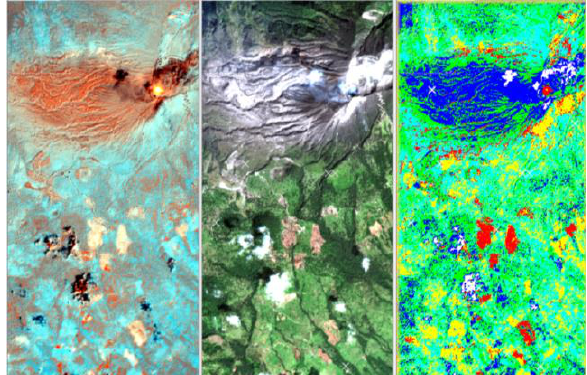
Figure 9. Check and test points for hydrothermal alteration (in red of K-means, right) for Sentinel 2 2017.